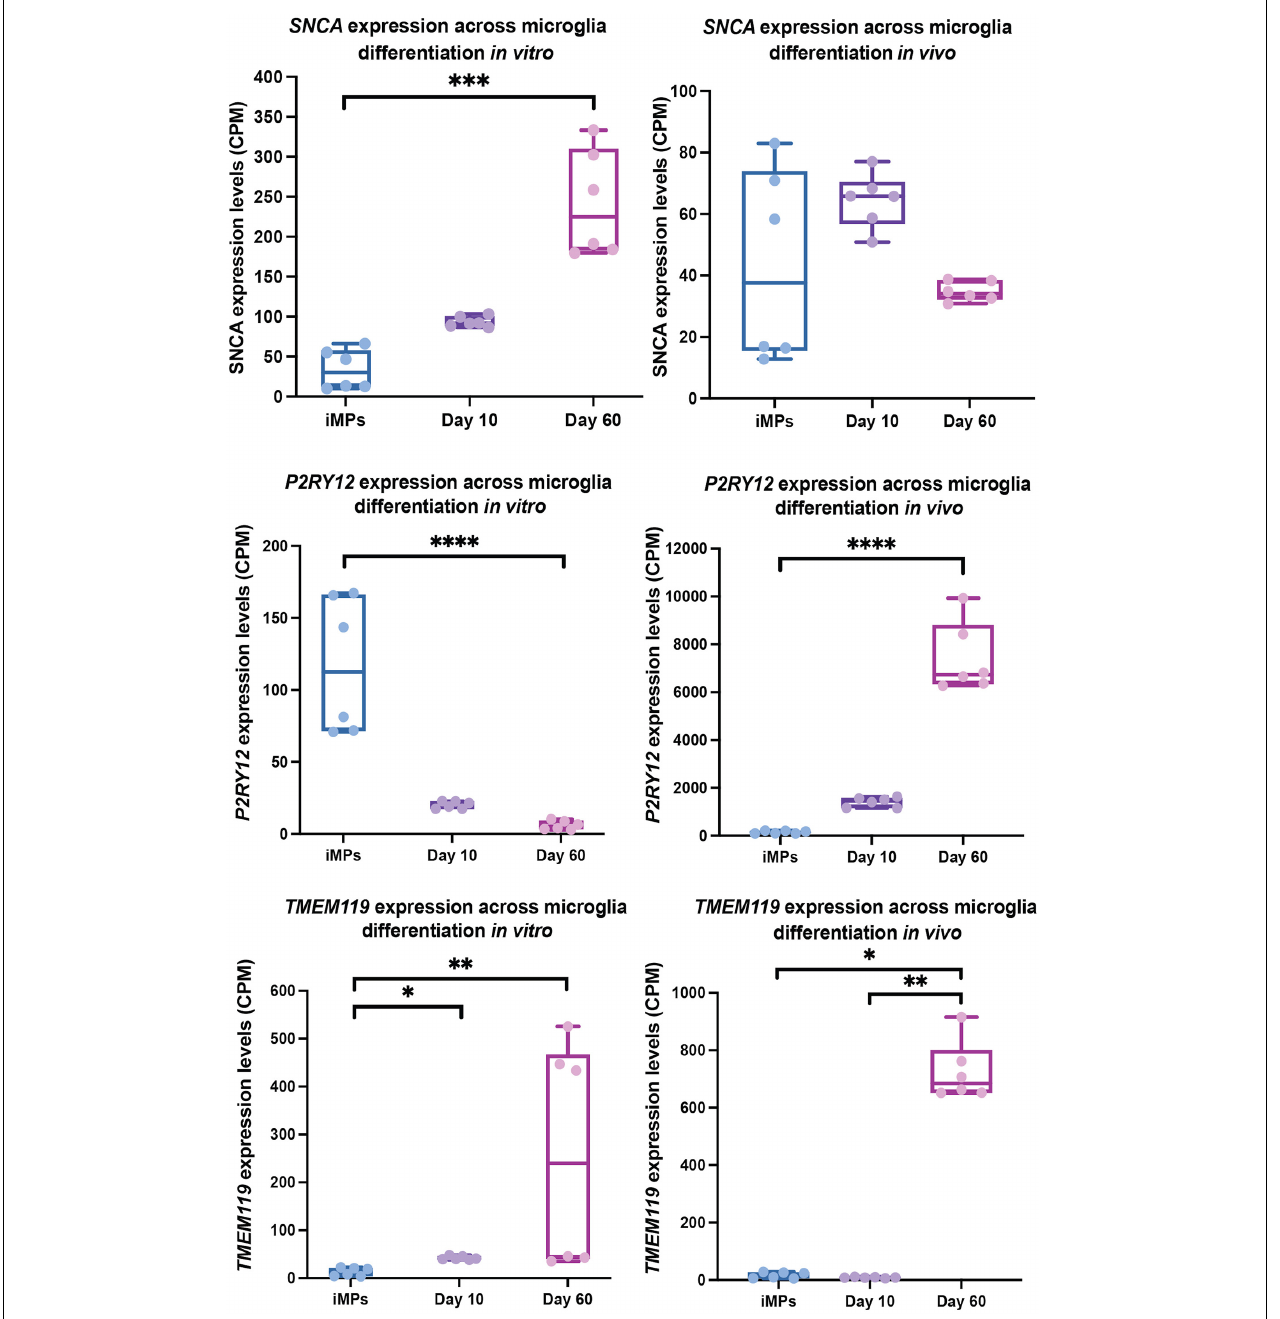
FIGURE 2 | SNCA, P2RY12, and TMEM119 expression in microglia precursors across differentiation in vivo and in vitro. This data is a re-analysis of publicly available data from Svoboda et al. (2019). CPM normalized expression levels of SNCA, P2RY12, and TMEM119 are shown for microglial iMPs (induced microglia precursors) that have been transplanted into mice and then differentiation in vivo (left) or differentiated in vitro (right) for 10 and 60 days. Significance between timepoints was determined using a Kruskal-Wallis test with Dunn’s Multiple Comparison ( ∗ p ≤ 0.05, ∗∗ p ≤ 0.01, ∗∗∗ p ≤ 0.001, ∗∗∗∗ p ≤